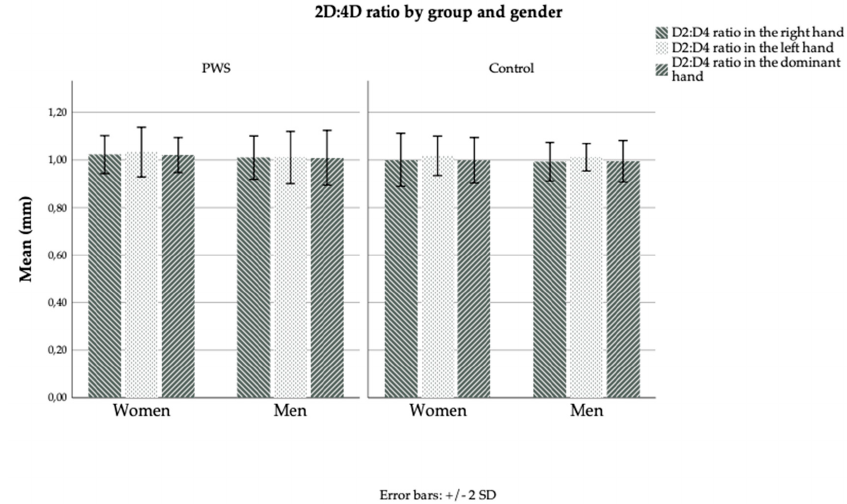
Chart 2. Characteristics of 2D:4D ratios by group (PWS participants vs. controls) and by